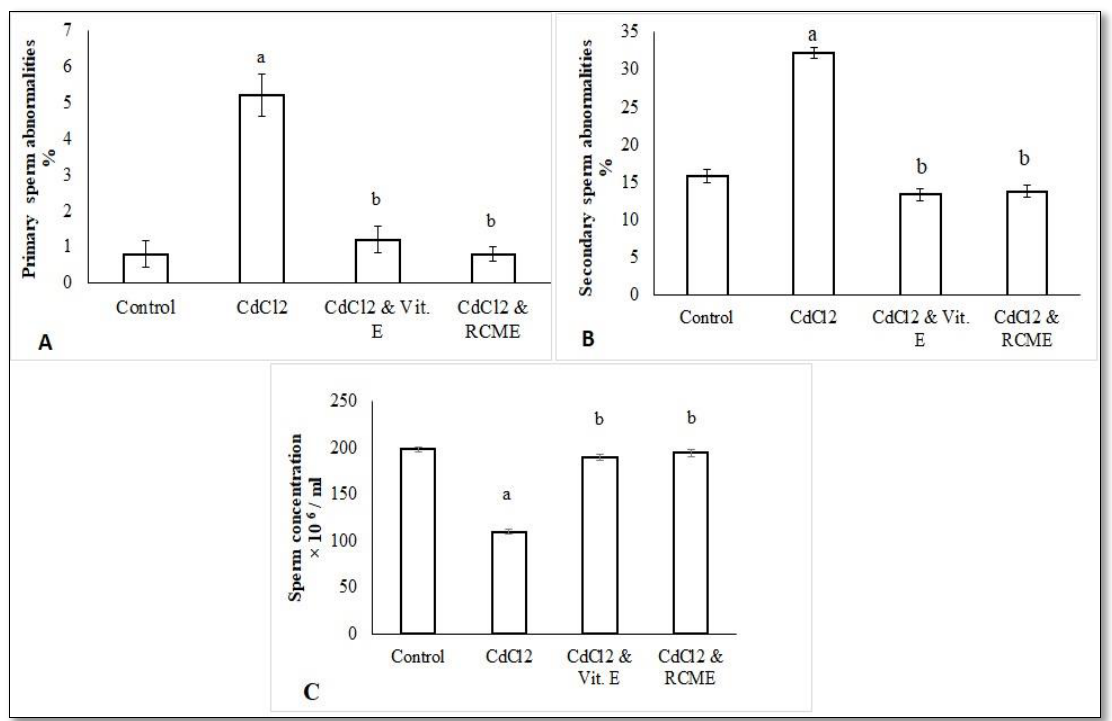
Figure 4. Mean values of primary ( A ) and secondary ( B ) sperm abnormalities as well as sperm concentration ( C ) in epididymal semen samples of control and treated rats. Each bar represents the mean ± SEM. a, p < 0.05 versus normal control. b. p < 0.05 versus CdCl 2 group. RCME: Red carrot methanolic extract.Vit. E: Vitamin E.